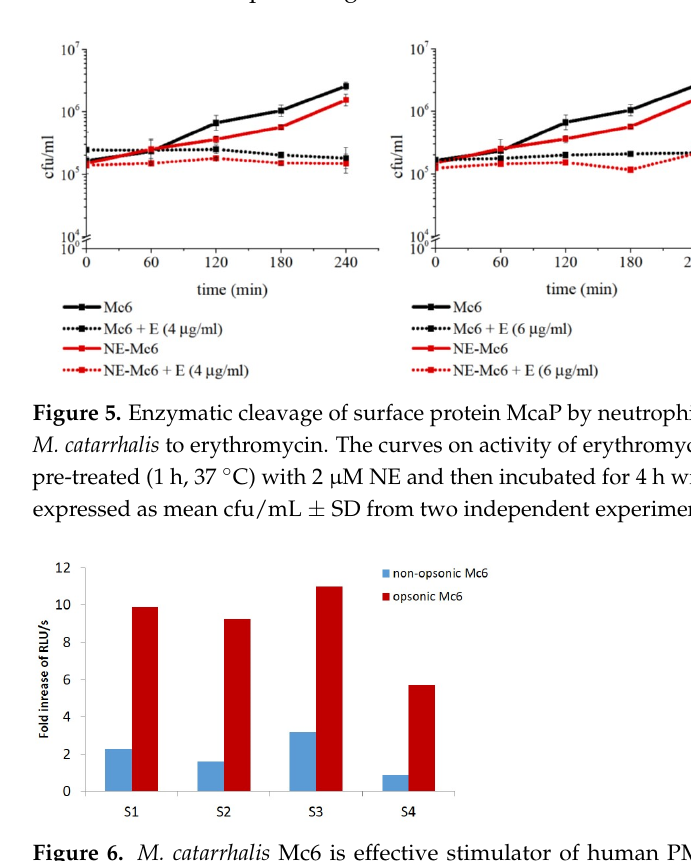
Figure 6. M. catarrhalis Mc6 is effective stimulator of human PMNs degranulation and elastase re- lease. Human neutrophil samples at ~1 × 10 7 cell/mL from four volunteers S1–S4 were primed with